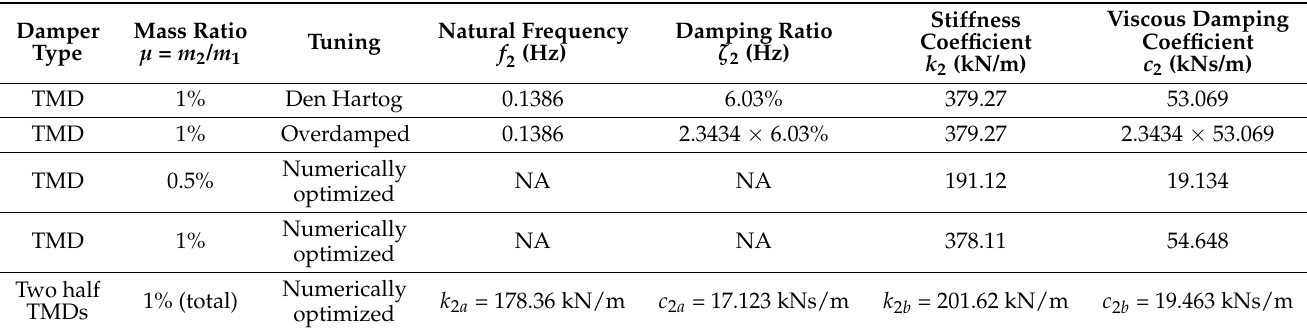
Table 2. Parameters of the considered